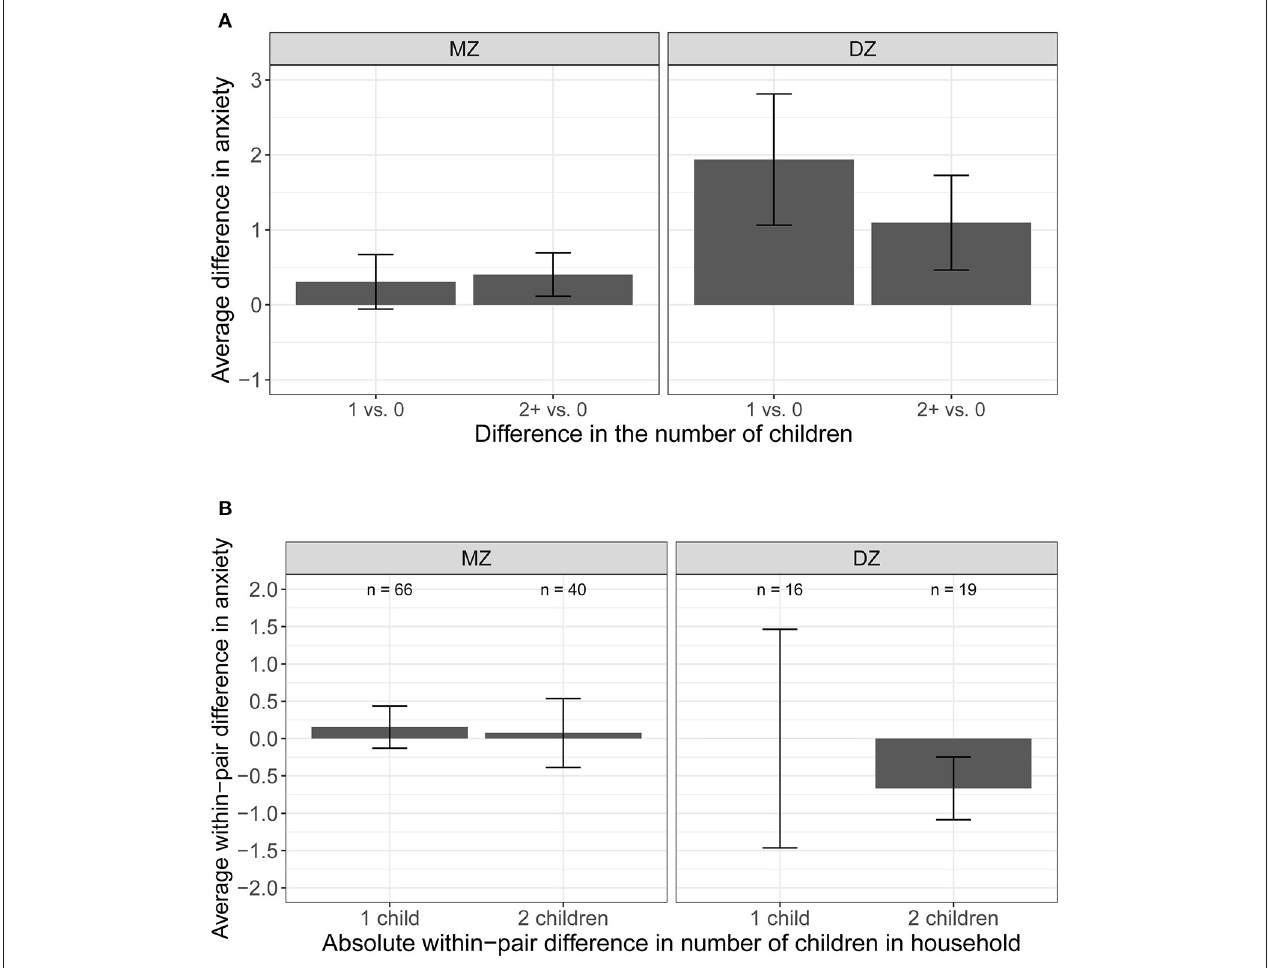
FIGURE 5 | Average difference and within-pair difference in anxiety levels and children. (A) Average difference in anxiety between participants with no children and one/two or more children in the household. (B) Average difference and within-pair difference in anxiety levels between